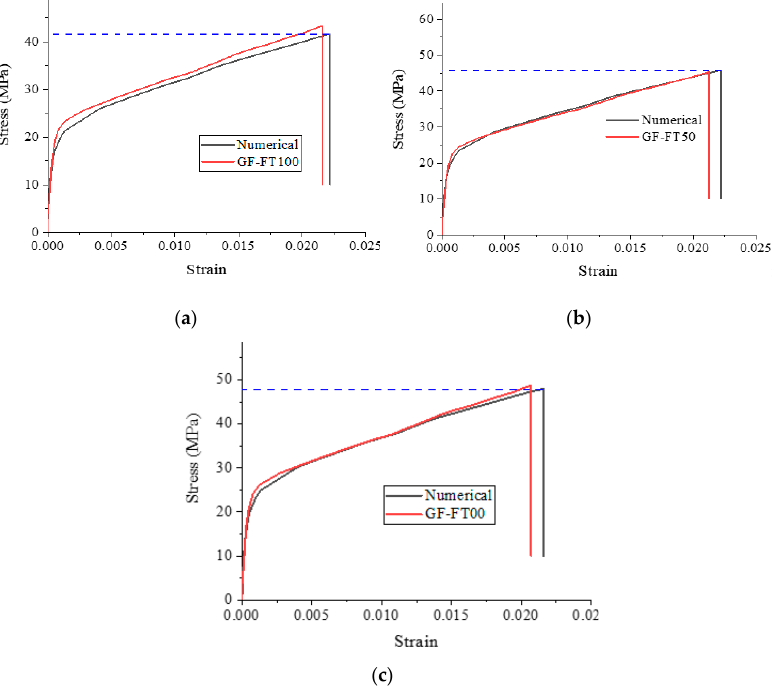
Figure 19. Uniaxial compressive stress–strain relationship for GFRP-reinforced specimens: ( a ) 0 freeze–thaw cycles; ( b ) 50 freeze–thaw cycles; ( c ) 100 freeze–thaw cycles.